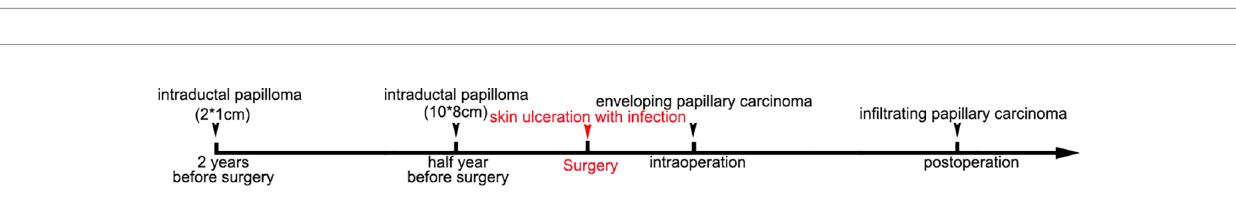
FIGURE 3 | Timeline of the patient ’ s medical history. Two years before surgery, the mass in the right breast was approximately 2 cm × 1 cm, and the puncture result was intraductal papilloma. The mass developed to be a size of 10 cm × 8 cm 18 months later, while the puncture result was intraductal papilloma. Subsequently, the skin was broken and severely infected. The intraoperative pathology was enveloping papillary carcinoma. The postoperative pathology was enveloping papillary carcinoma with in fi ltrating papillary carcinoma and (9/12) lymph node